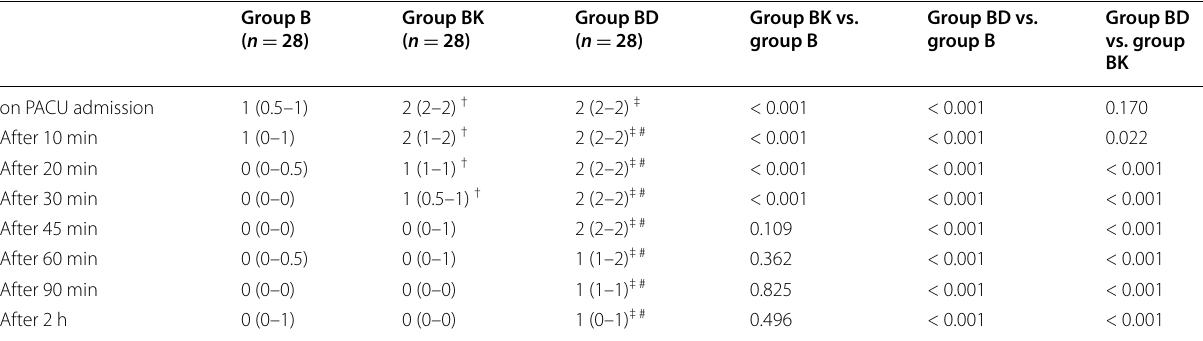
† Statistically significant ( P value < 0.05) (group BK versus group B) ‡ Statistically significant ( P value < 0.05) (group BD versus group B) # Statistically significant ( P value < 0.05) (group BD versus group BK)